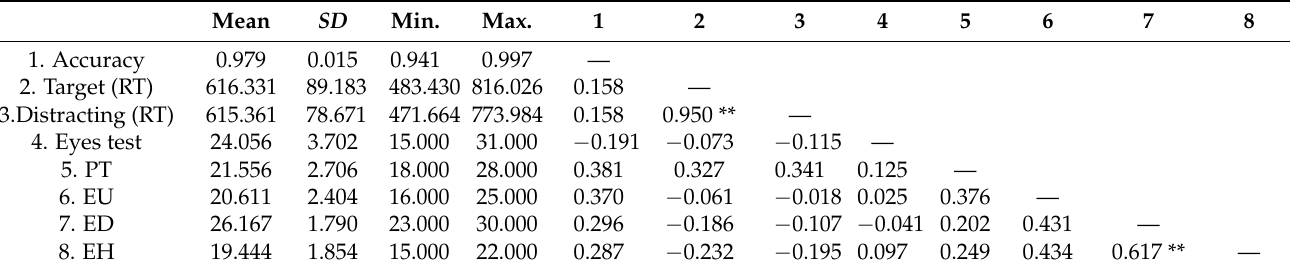
Table 1. Descriptive Statistics of the variables under study. The numbers 1–8 are the variables in the first